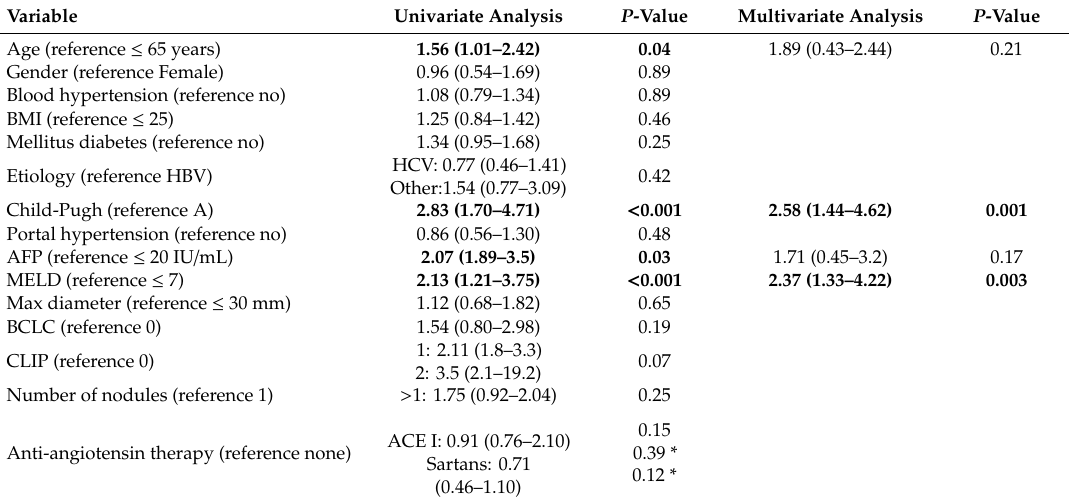
Table 2. Univariate / multivariate analysis of prognostic factors for overall